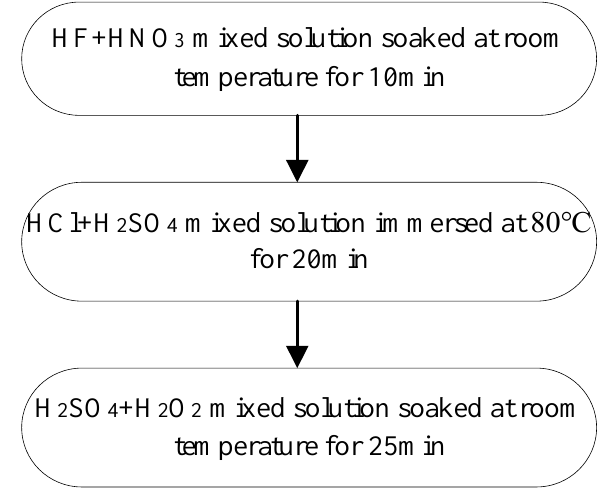
Figure 7. Process of acid-etching treatment.